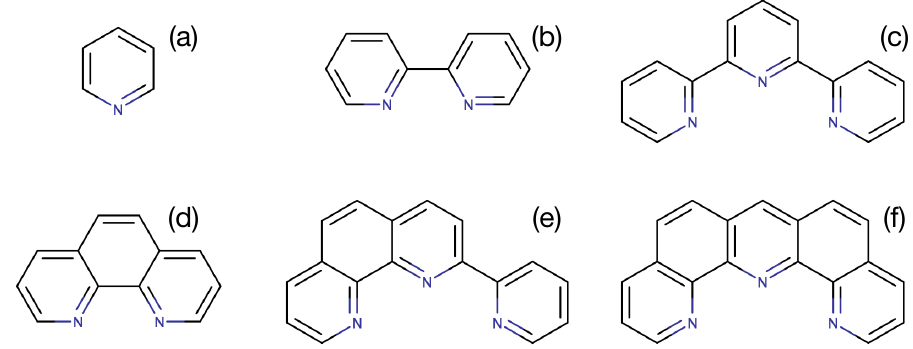
Figure 2. Six ligands of increasing size used to lower the energy of the MLCT state in Fe(II) complexes. ( a ) pyridine, ( b ) bipyridine, ( c ) terpyridine, ( d ) phenantroline, ( e ) 2-(2-pyridyl)-1,10-phenanathroline, ( f ) dipyrido-[4,3-b;5,6-b] acridine.